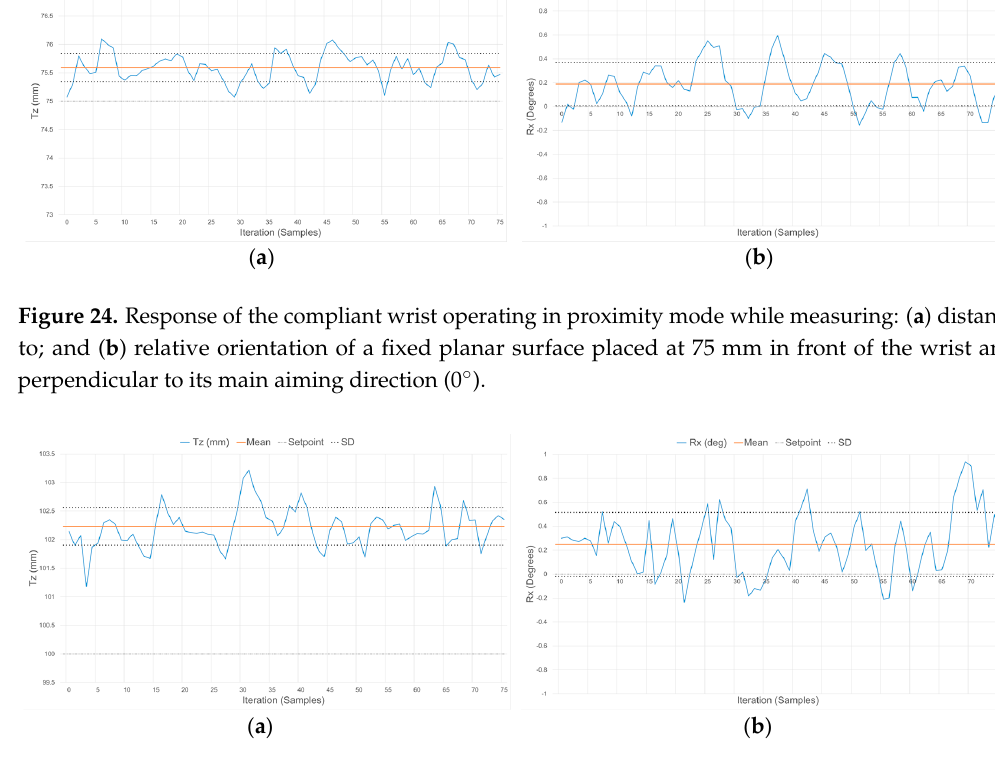
Figure 25. Response of the compliant wrist operating in proximity mode while measuring: (a) distance to; and (b) relative orientation of a fixed planar surface placed at 100 mm in front of the wrist and perpendicular to its main aiming direction (0°). Table 3. 3-DOF transformation parameters measured when operating at three different distances